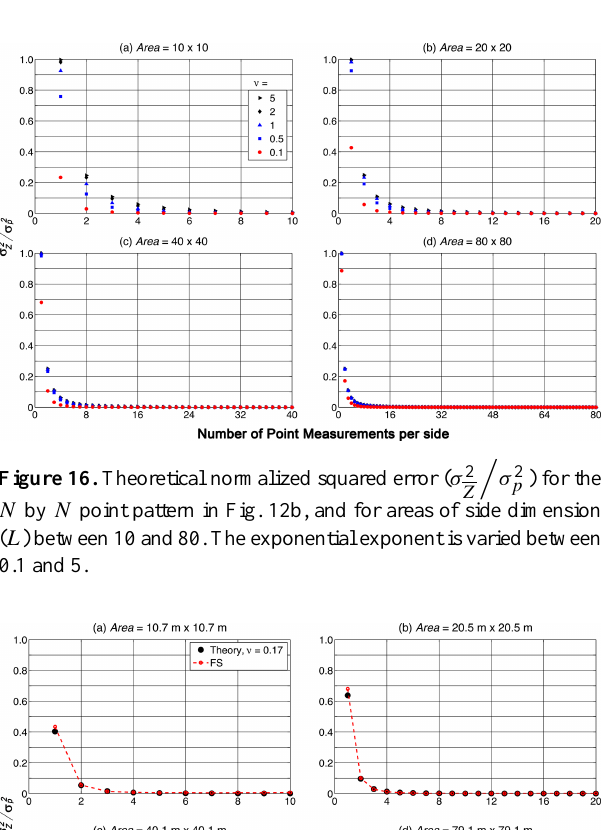
Figure 17. Theoretical and sampled normalized squared error . σ 2 p ) for the N by N point pattern in Fig. 12b, and over square ( σ 2 Z areas of side dimensions ( L ) between 10.7 and 79.1m. The solid black point markers are the theoretical error for an exponential de- cay exponent of 0.17 derived from the sampled correlogram of snow depth in FS. The dotted red lines with circle markers are the sam- pled normalized squared error for the snow cover in